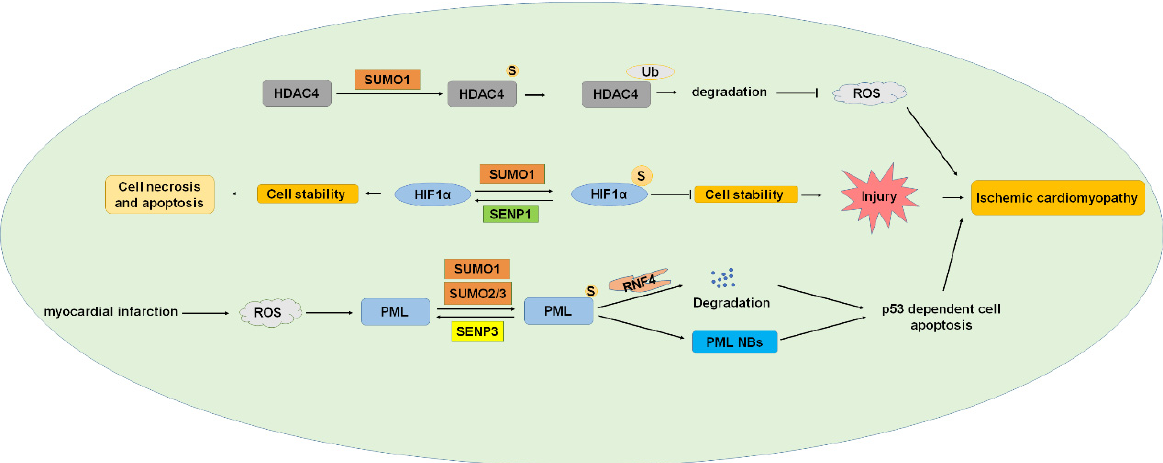
Figure 6. SUMOylation and ischemic cardiomyopathy. HDAC4, HIF1 α , and PML were SUMOylated, and SUMOylation of these proteins played essential roles in developing ischemic cardiomyopathy. HDAC4, histone deacetylase 4; HIF1 α , hypoxia-inducible factor 1 α ; PML, promyelocytic leukemia. S: SUMO.